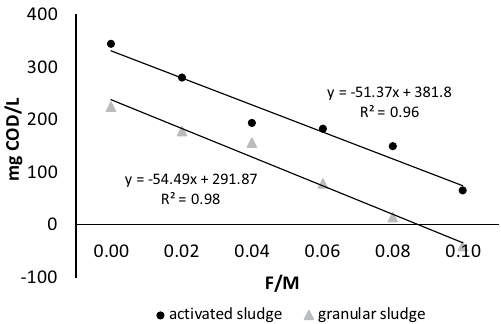
Figure 2. Relationship between the change in COD concentration during the experiment and the F/M ratio at the beginning of the experiment; values on the vertical axis correspond to the increase or decrease in COD concentration during the experiment.